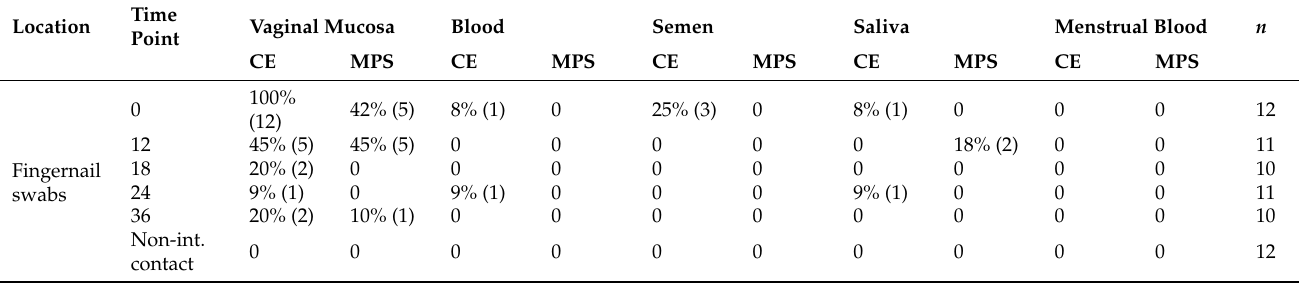
Table 1. The percentage of samples (exact numbers in brackets) in which the various body fluids present in both assays (CE and MPS) were “detected” according to the respective scoring rules. The last column shows the total number of samples analyzed in each category ( n ).